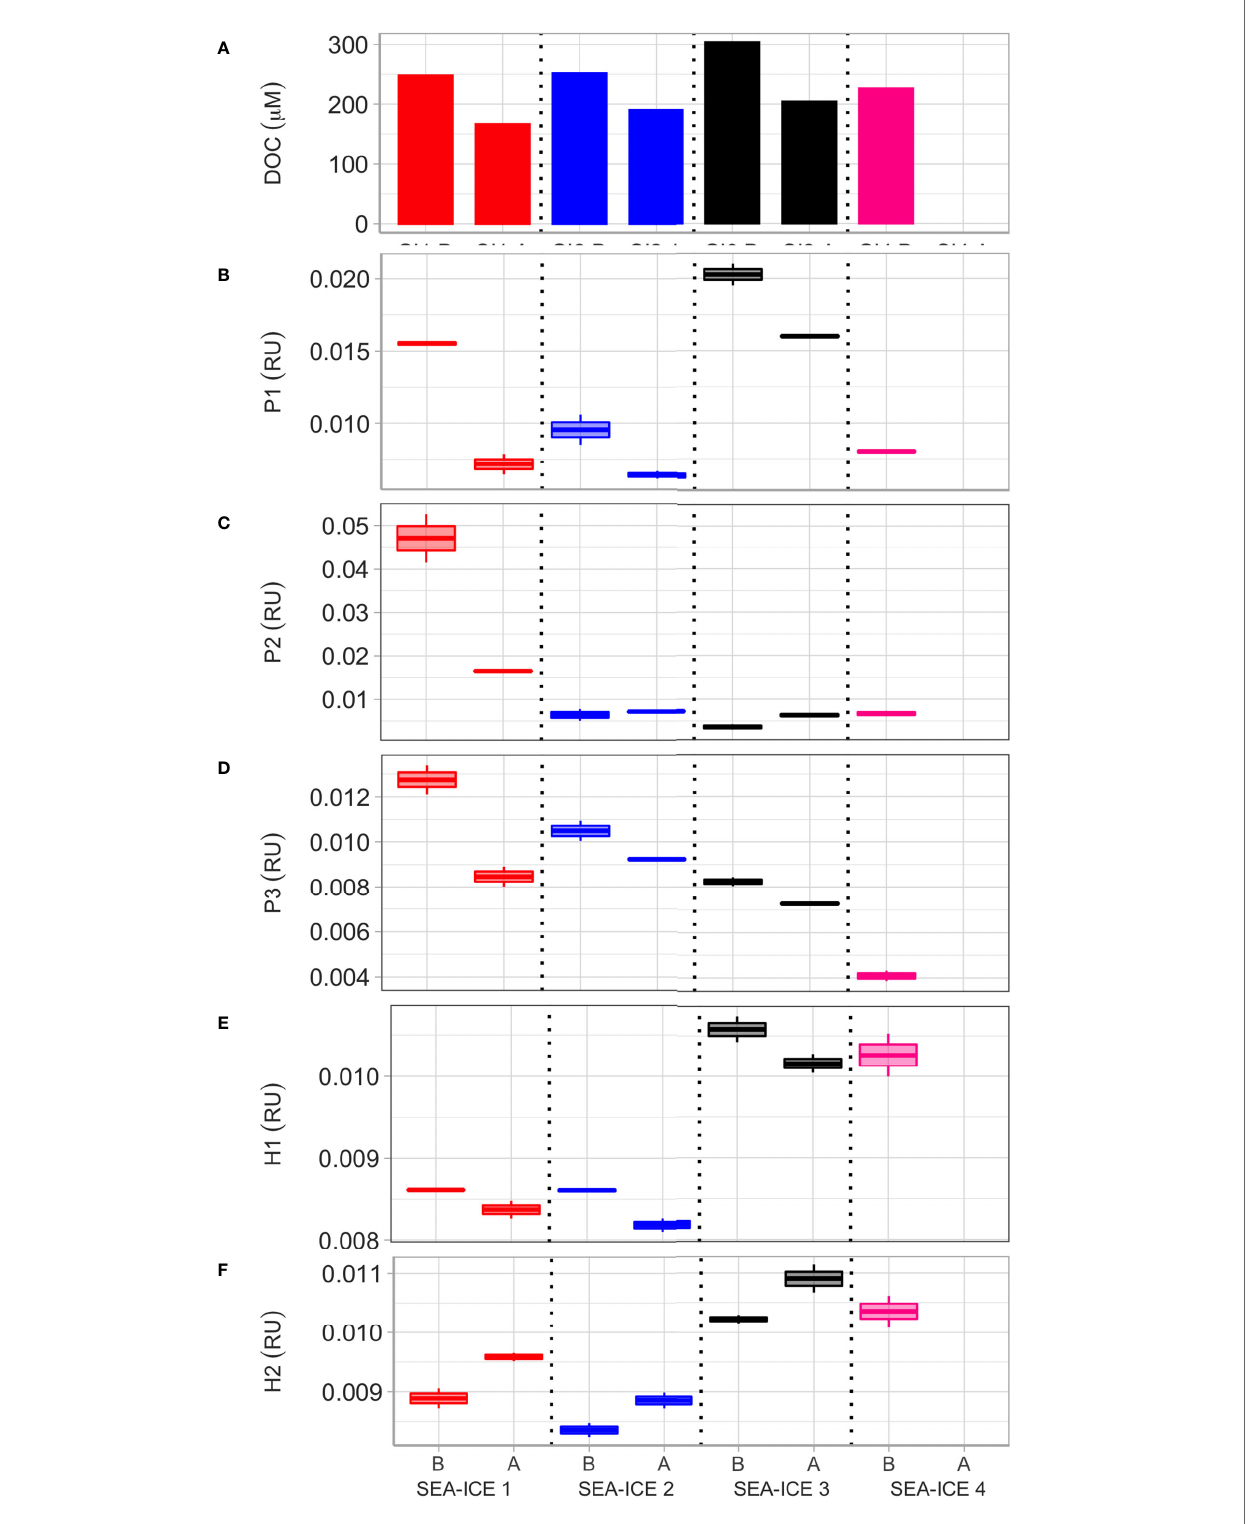
FIGURE 5 | Dissolved organic matter properties in the four experiments before ( “ B ” ) and after ( “ A ” ) bubbling. From top to bottom, panels show dissolved organic carbon (DOC) concentration (A) ; fl uorescence of PARAFAC protein-like components P1 (B) , P2 (C) , P3 (D) , and of humic-like components H1 (E) and H2 (F)